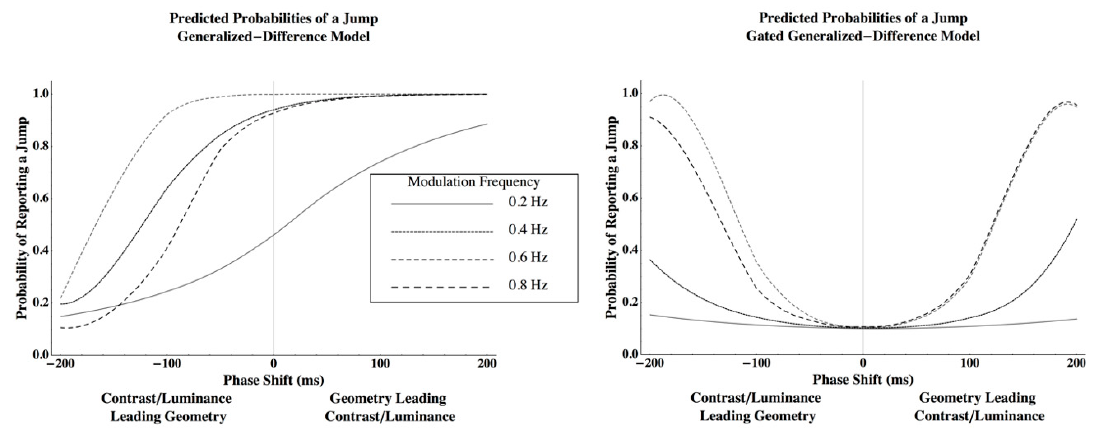
Figure 1. Predictions from the Generalized Difference Model (left) and the Gated Generalized Difference Model (right) when a geometric disparity modulation is used to cancel the perceived rotation induced by a contrast or average luminance disparity modulation. The probability of a jump corresponds to the probability of a brief rotation induced by one disparity before being cancelled by the second disparity. The details concerning the algorithm that was used to generate these predictions can be viewed in Appendix B.